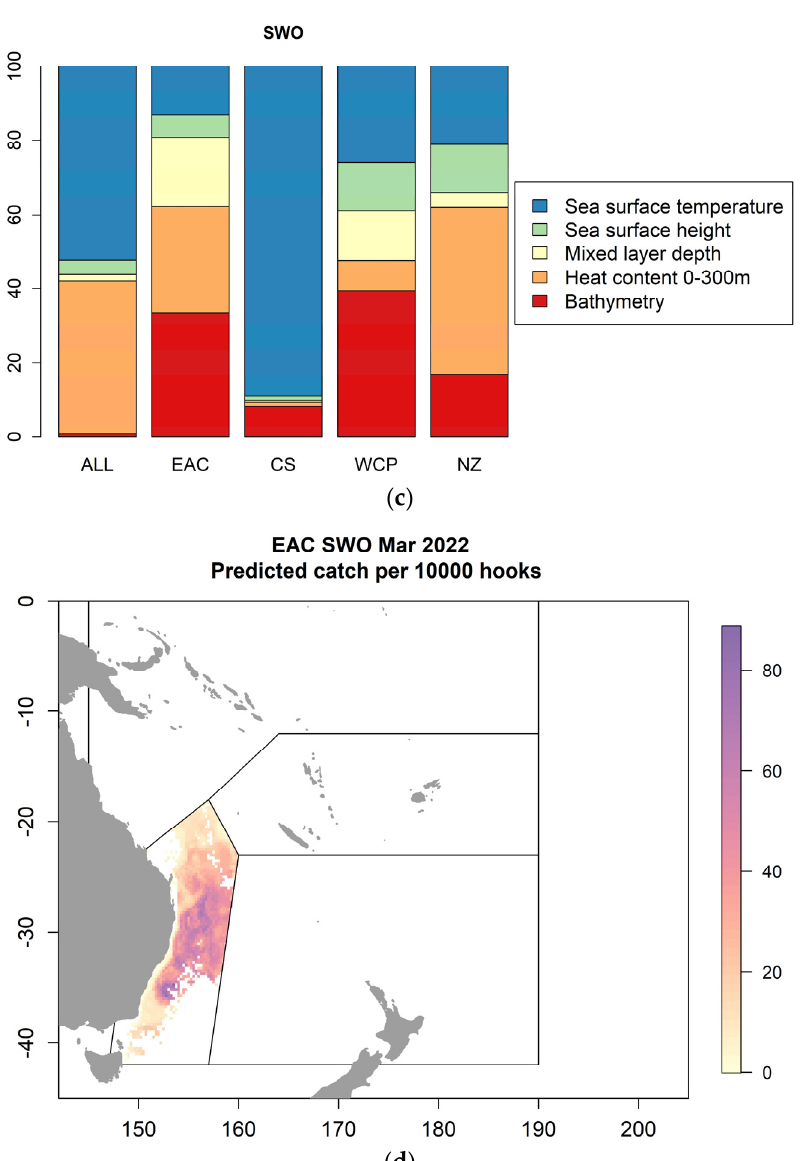
Figure 3. ( a ) Data and delivery steps for an SBT habitat report: southern bluefin tuna are tagged in the study region, and from these tags, temperature at depth data is matched with real-time oceanographic data to produce a habitat nowcast, which is then used by fisheries managers to implement spatial management zones; ( b ) Seasonal forecast of habitat zones: The monthly mean position of the boundaries between core and buffer zones (lower line), and buffer and OK zones (upper line) for 1994–2013 is indicated by the yellow band. The blue lines indicate the maximum northerly and southerly extent of these boundaries recorded during the period. The position of the habitat boundaries in the current year (2014) up to the date of the current habitat nowcast is depicted by the red band. Red stars represent forecasts from a seasonal forecast model for the location of the southern habitat boundary for future months; ( c ) relative contributions of each of the oceanographic variables included in the boosted regression tree forecasting models for swordfish for all regions (ALL = whole region; EAC= East Australia Current dominated region; CS = Coral Sea; WCP = Western Central Pacific; NZ = New Zealand) for all years in the validation dataset (2016–2020) for SWO; ( d ) example ecoforecast of predicted catch per unit effort for swordfish in the EAC area.